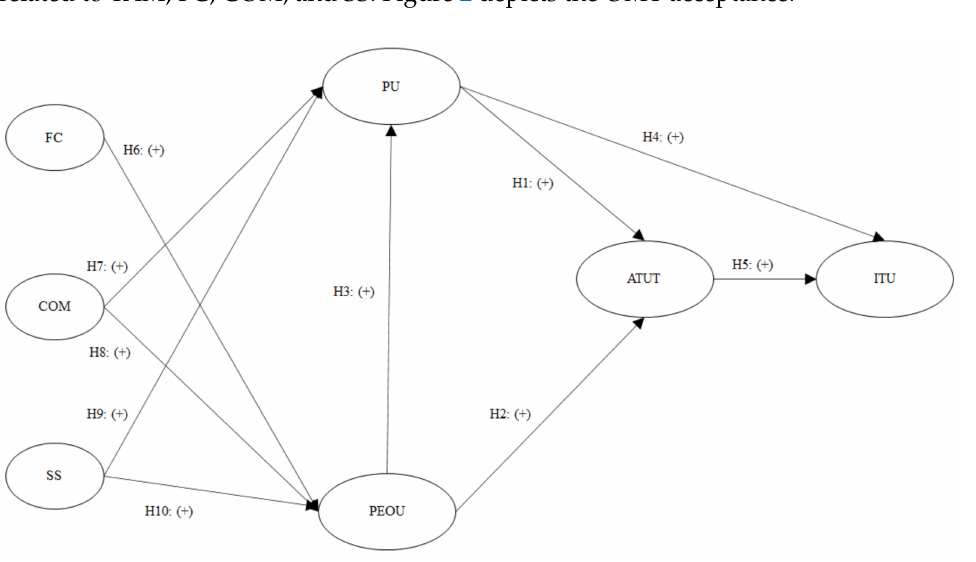
Figure 2. OMT acceptance model for older